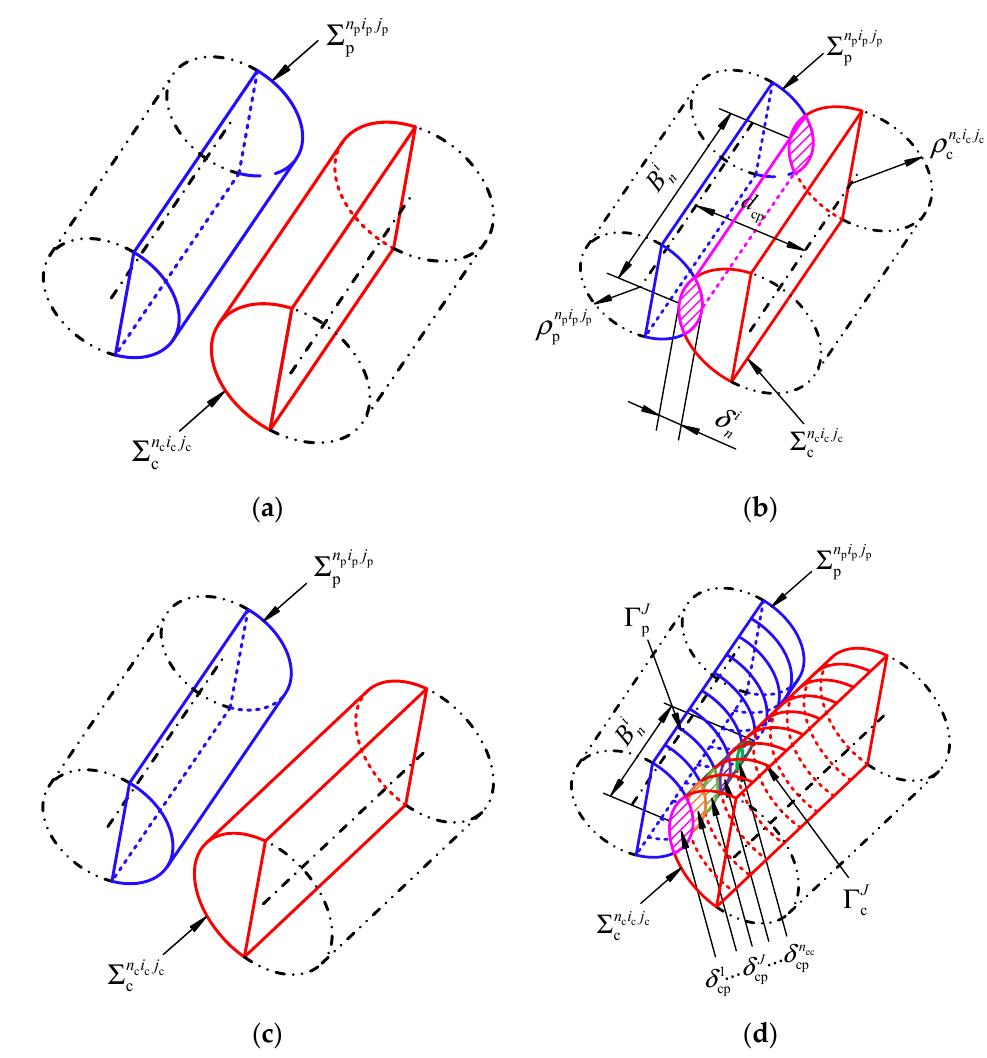
Figure 6. Four contact status for any two elements on each group of slices: ( a ) elements separation without φ and γ , ( b ) elements contact without φ and γ , ( c ) elements separation considering φ and γ , ( d ) elements contact considering φ and γ .